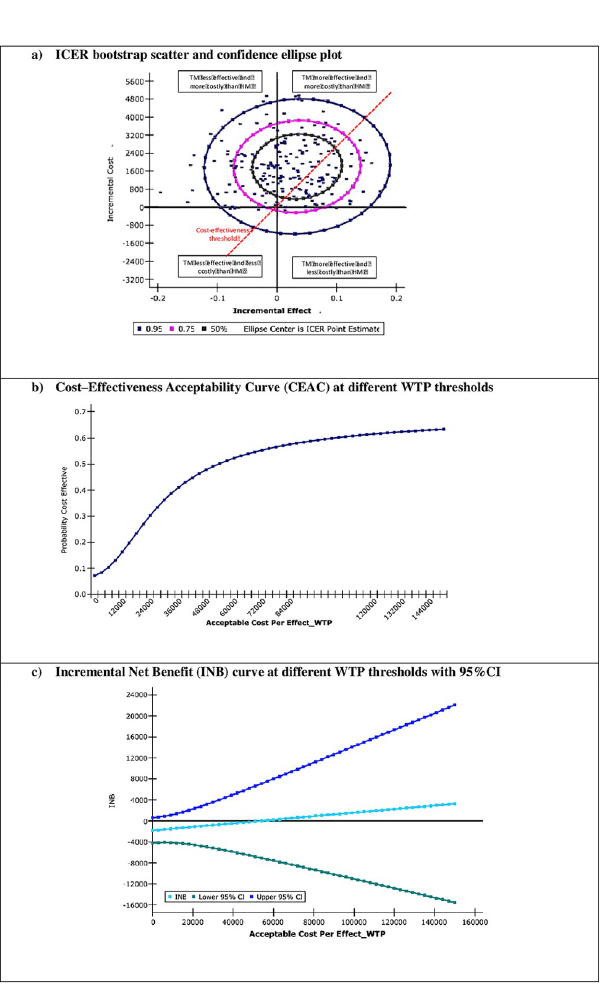
Fig 2. Incremental costs per QALY from NHS perspective; probabilistic sensitivity analysis. NHS: National Health System; TM: Telemonitoring; CM: Conventional Monitoring group; QALY: Quality Adjusted Life Year; ICER: Incremental Cost-effectivenes Ratio; WTP: Willingness to Pay.